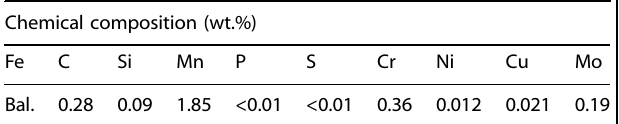
Table 1. Chemical composition of the ultra-high-strength steel substrate.